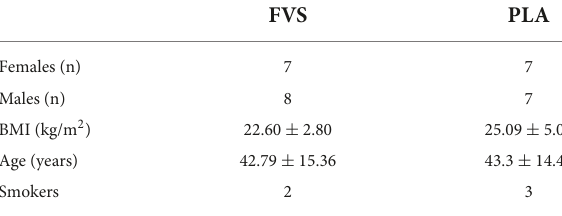
TABLE 1 Demographic data of the study